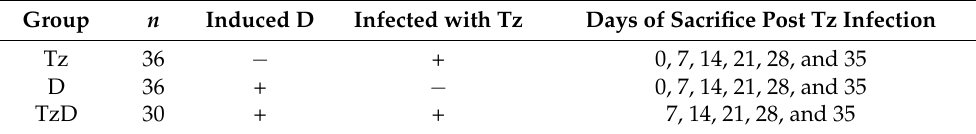
Table 1. Experimental